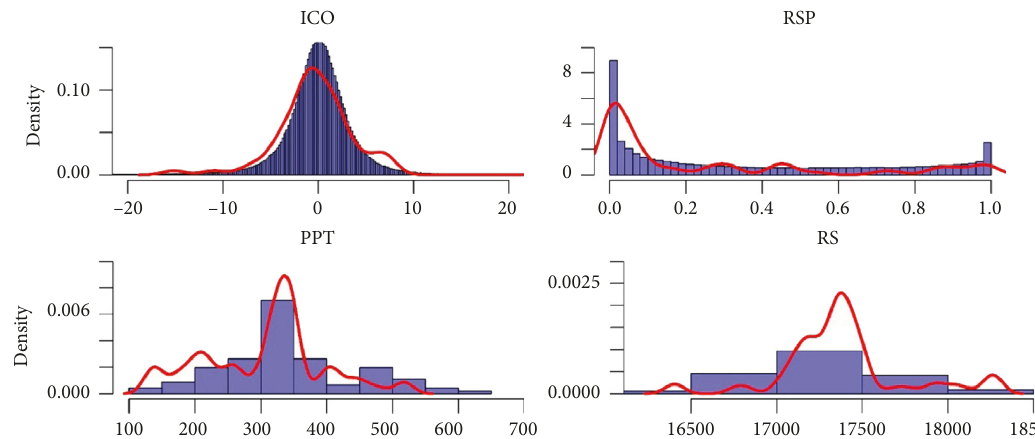
Figure 2: Histograms of population density (blue bars) and sample density (red lines).